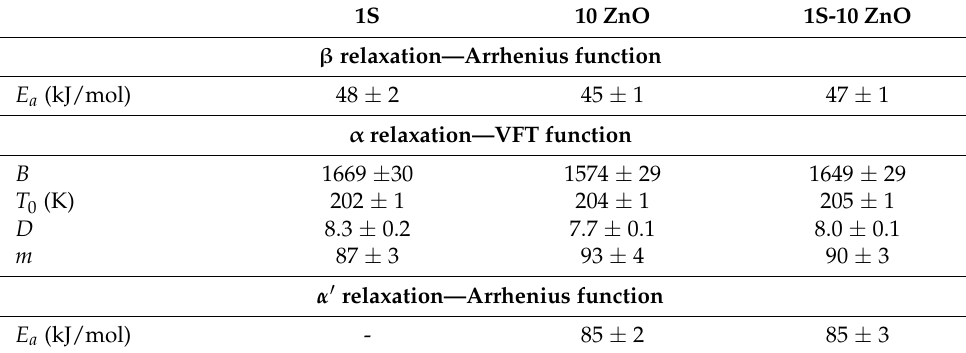
Table 3. Arrhenius and VFT fit parameters in activation diagrams. 1S 10 ZnO 1S-10 ZnO β relaxation—Arrhenius